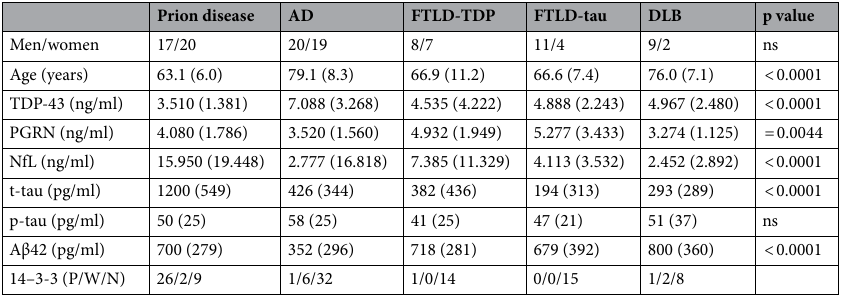
Table 1. Summary of the results for prion diseases, Alzheimer’s disease (AD), frontotemporal lobar degeneration with TDP-43 inclusions (FTLD-TDP), frontotemporal lobar degeneration with tau inclusions (FTLD-tau), and dementia with Lewy bodies (DLB). Demographic data are shown as actual numbers or means (SD), biomarker levels as means (SD). P-values represent the approximate two-tailed p-values of the Kruskal– Wallis test when comparing all groups (p < 0.05). TAR DNA binding protein (TDP)-43; progranulin (PGRN); neurofilament light chain (NfL); total-tau (t-tau); phosphorylated-tau (181P) (p-tau); amyloid-beta (1–42) (Aβ42); P = positive, W = weak, N =